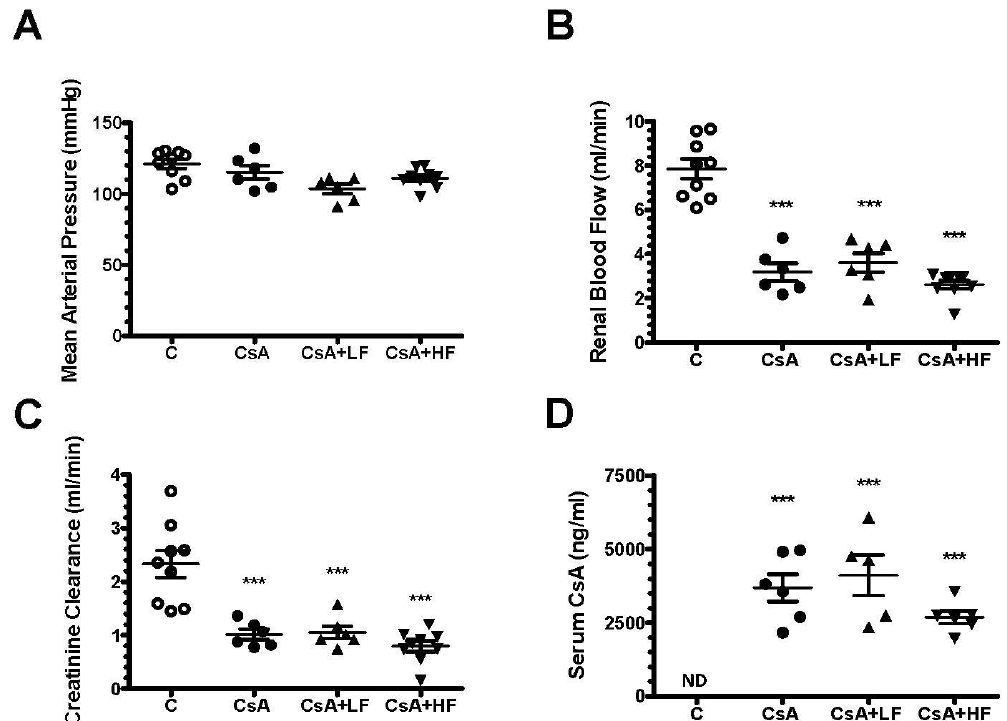
Figure 2. Fosfomycin does not alter renal dysfunction induced by cyclosporine. Four groups of rats were studied: control (C, white circles), cyclosporine (CsA, black circles), CsA with a low dose of fosfomycin (CsA + LF, black triangles up), and CsA with a high dose of fosfomycin (CsA + HF, black triangles down). At the end of the study, ( A ) mean artery pressure, ( B ) renal blood flow, ( C ) creatinine clearance, and ( D ) serum cyclosporine were determined. n = 6 to 9 per group. *** p < 0.001 vs. control group.